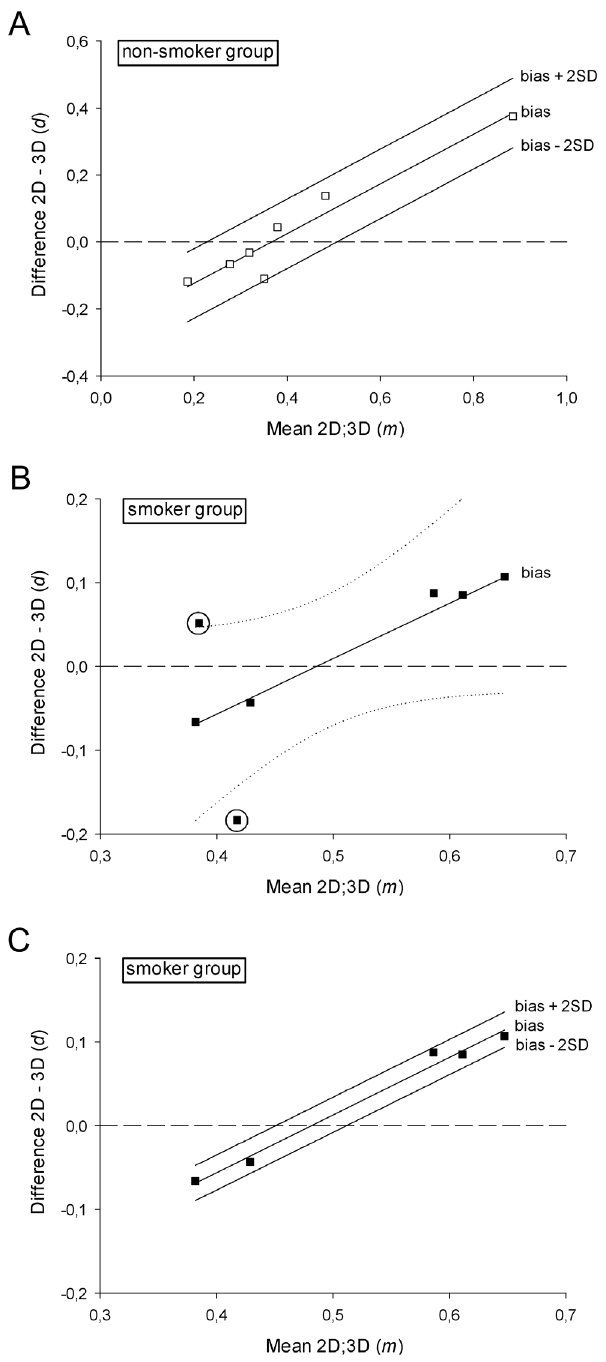
Figure 7. A clear correlation between the difference and the mean magnitude can be noticed for both groups. Dashed line y=0 represents the line of equality, which stands for perfect agreement. (a) Regression based mean difference (bias) and 95% limits of agreement for the differences of the CD68 + /CD3 + cell density ratios as determined by the 2D nucleus and 3D approaches in the non-smoker group. All values lie within the interval between the calculated 95% limits of agreement; (b) Regression based mean difference (bias) with 95% C.I. of the regression line (dotted) for the differences of the CD68 + / CD3 + cell density ratios in the smoker group. The 95% C.I. includes several horizontal lines (slope=0) so that the fitted linear model does not achieve the desired statistical significance. Two large outliers encircled; (c) Regression based mean difference (bias) and 95% limits